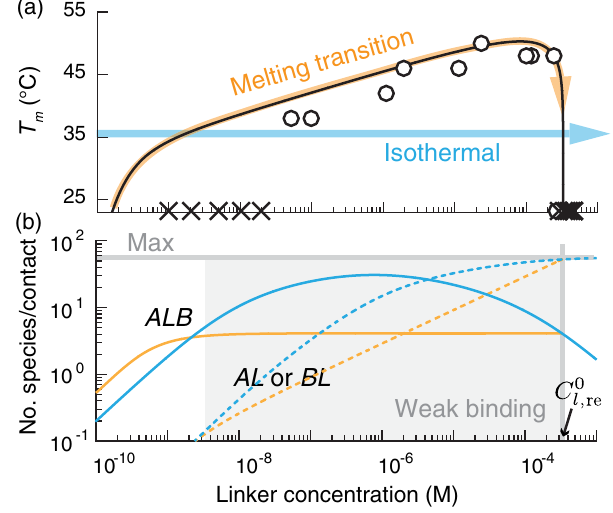
Linker concentration (M) FIG. 4. Predictions of the melting temperature T m and number of bound molecular species per contact between particles versus linker concentration. (a) The full theory predicts a phase diagram that matches experimental measurements (points) quantitatively above linker concentrations of roughly 10 nM. (b) Predictions of the number and type of bound molecular species — either bridges (solid lines) or half-bridges (dashed lines) — between a pair of interacting particles help explain our observations. Orange curves show the number of molecular species at the melting transition [the orange path in (a)]; blue curves show the number of bridge and half-bridge species at a fixed temperature: T ¼ 35 °C [the blue path in (a)]. Linker concentrations with a constant number of bridges at the melting transition correspond to the weak-binding limit. The horizontal gray line shows the maximum number of possible bound species; the vertical gray line shows the reentrant